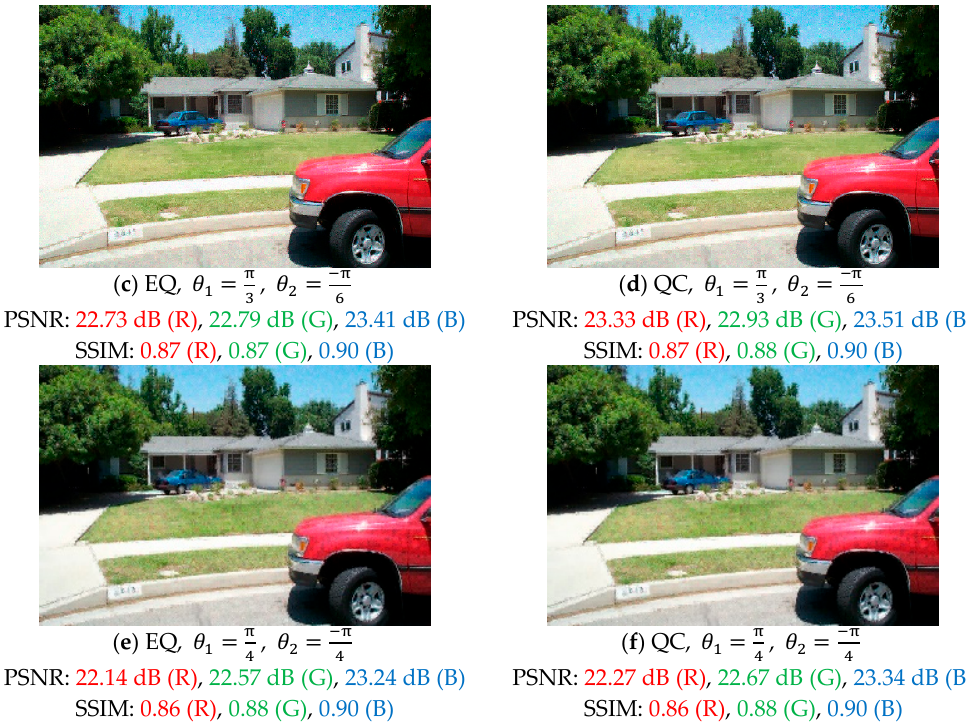
Figure 15. Demonstration of angle selection in multiple description coding with equality and quadratic constraints. BCS coe ffi cients experience lossy rate of p e ,1 = p e ,2 = 0.1 in three planes. Appl. Sci. 2019 , 9 , x